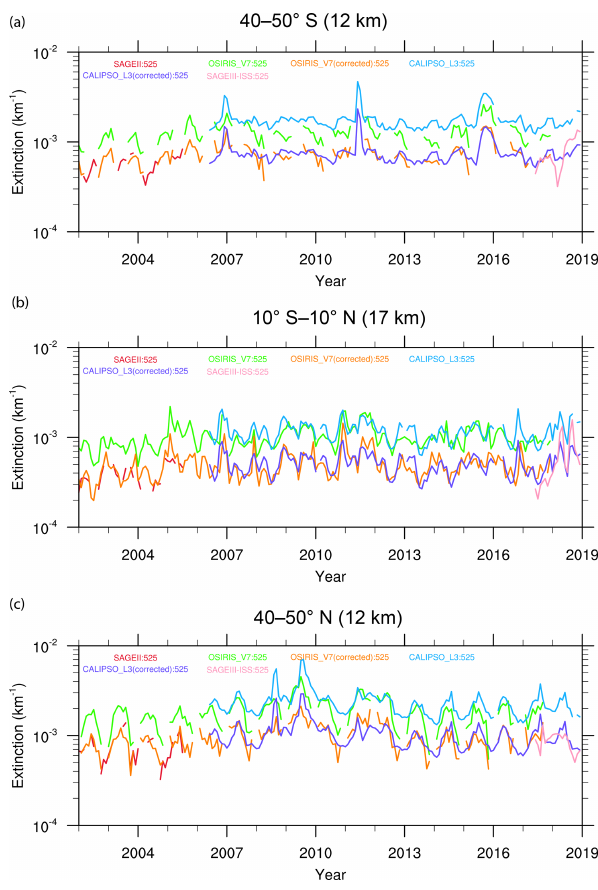
Figure 10. Zonally averaged monthly time series plots of the ex- tinction coefficient at 525nm for different latitude bands and alti-